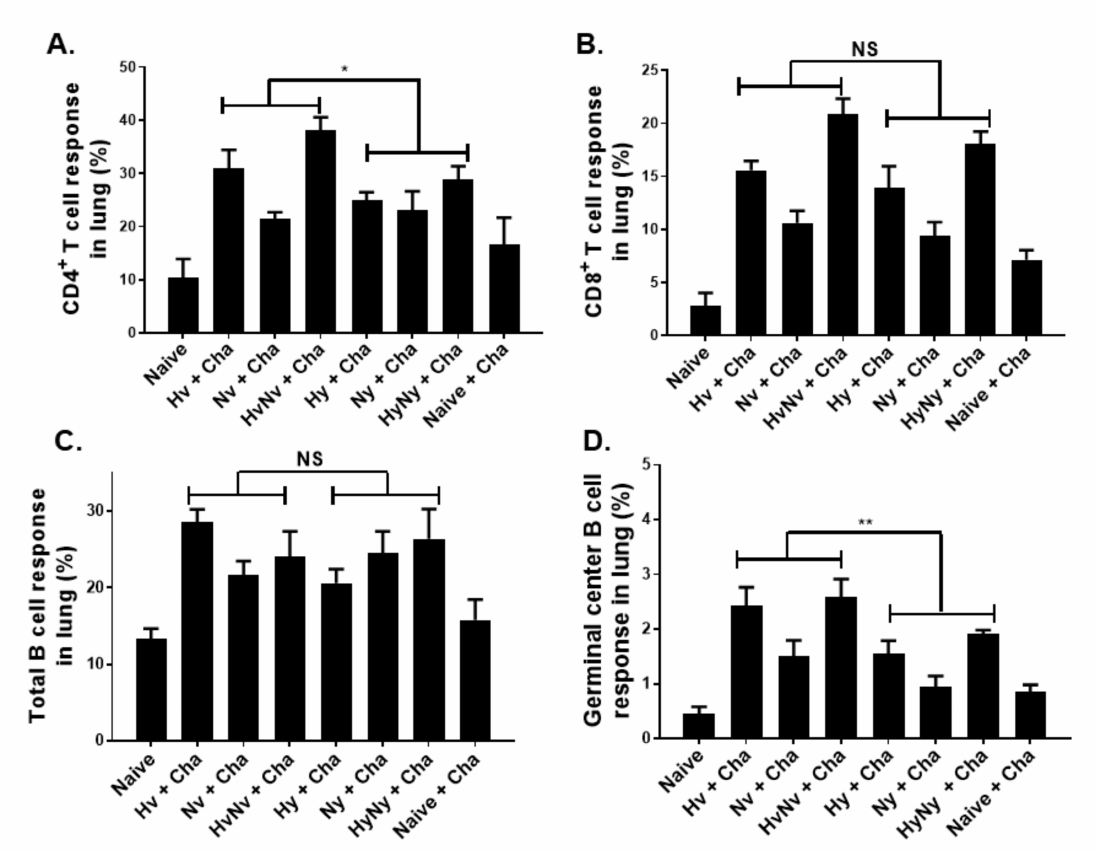
Figure 5. Cellular immune responses after influenza B virus challenge infection. Lung cells were stained with fluorophore-conjugated antibodies and gated to quantify changes in various cell popula- tions. CD4+ T cell ( A ), CD8+ T cell ( B ), total B cell ( C ), and germinal center B cells ( D ) inductions post-challenge with B/Colorado/06/2017 virus were evaluated by flow cytometry. Naïve+Cha refers to those naïve mice who were challenge infected with a lethal dose of influenza virus. Data are expressed as mean ± SD with asterisks denoting statistical significance between groups (* p < 0.05, ** p < 0.01; NS: not